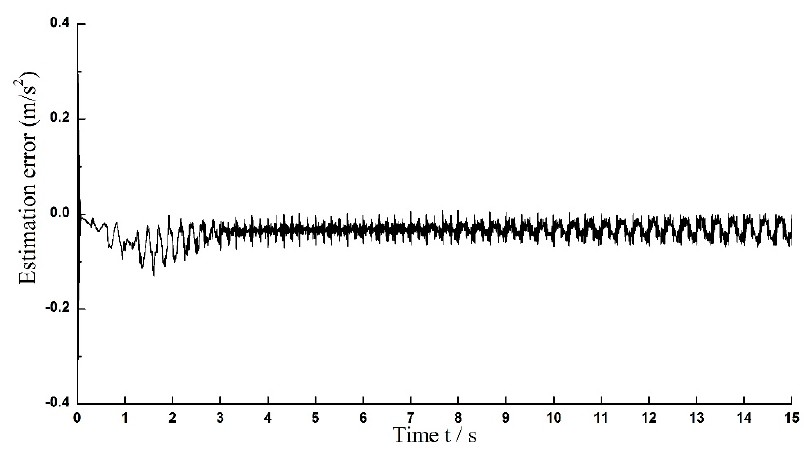
Figure 14. The estimation error of experiment result.